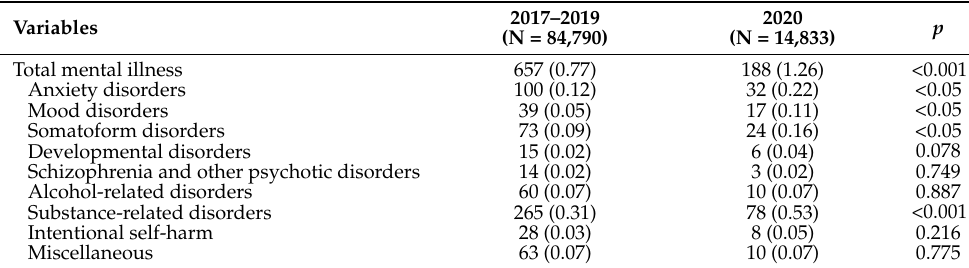
Table 2. The proportion of 5–17-year-old patients with mental illness visiting the pediatric emergency